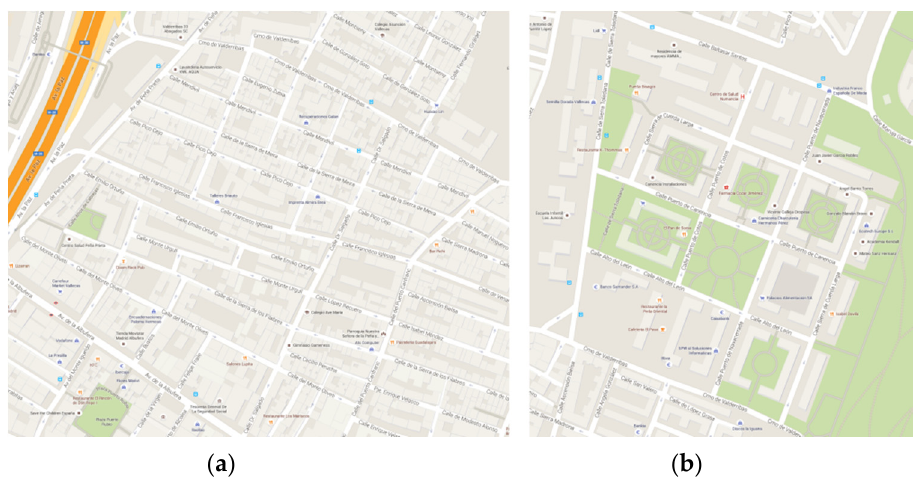
Figure 2. Test areas. ( a ) Route 1; ( b ) Route 2.